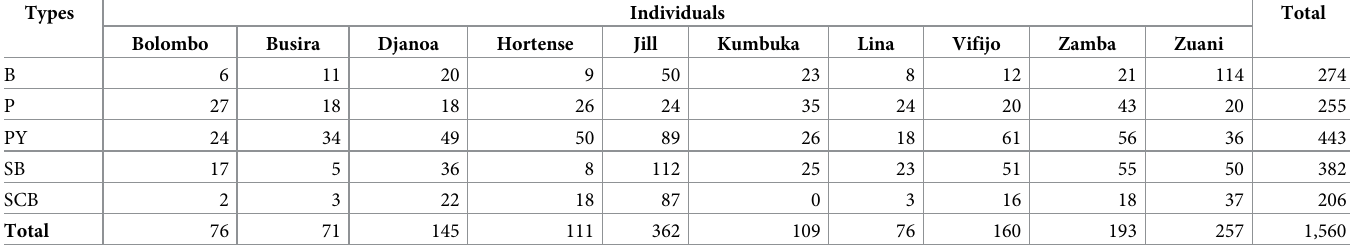
Bark (B), Scream Bark (SCB), Whining Whistle (WW), Whistle (W), and Scream Whistle (SCW). For the automatic classification tasks reported in Sections II and III, we selected the ten individuals (7 females, 3 males) for whom at least 70 calls were available from the five most Table 1. Number of calls per individual and per call type in the dataset used for automatic classification. The five call types are: Bark (B), Peep (P), Peep Yelp (PY), Soft Bark (SB), and Scream Bark (SCB).